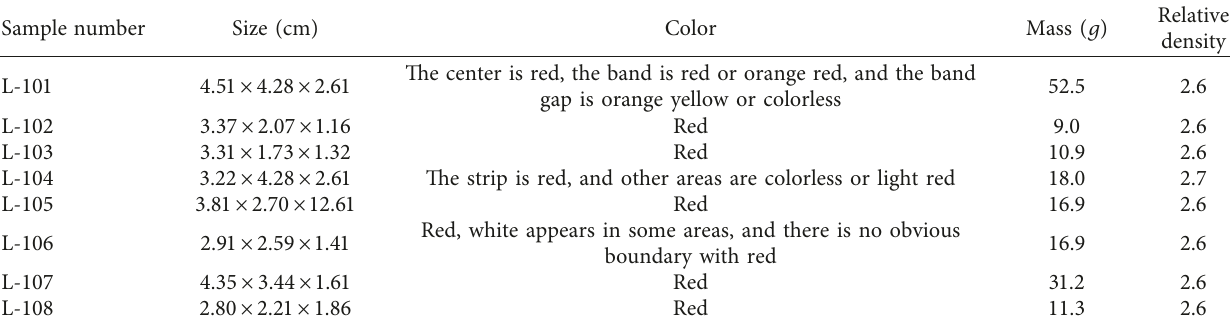
Table 1: Basic characteristics of “combined